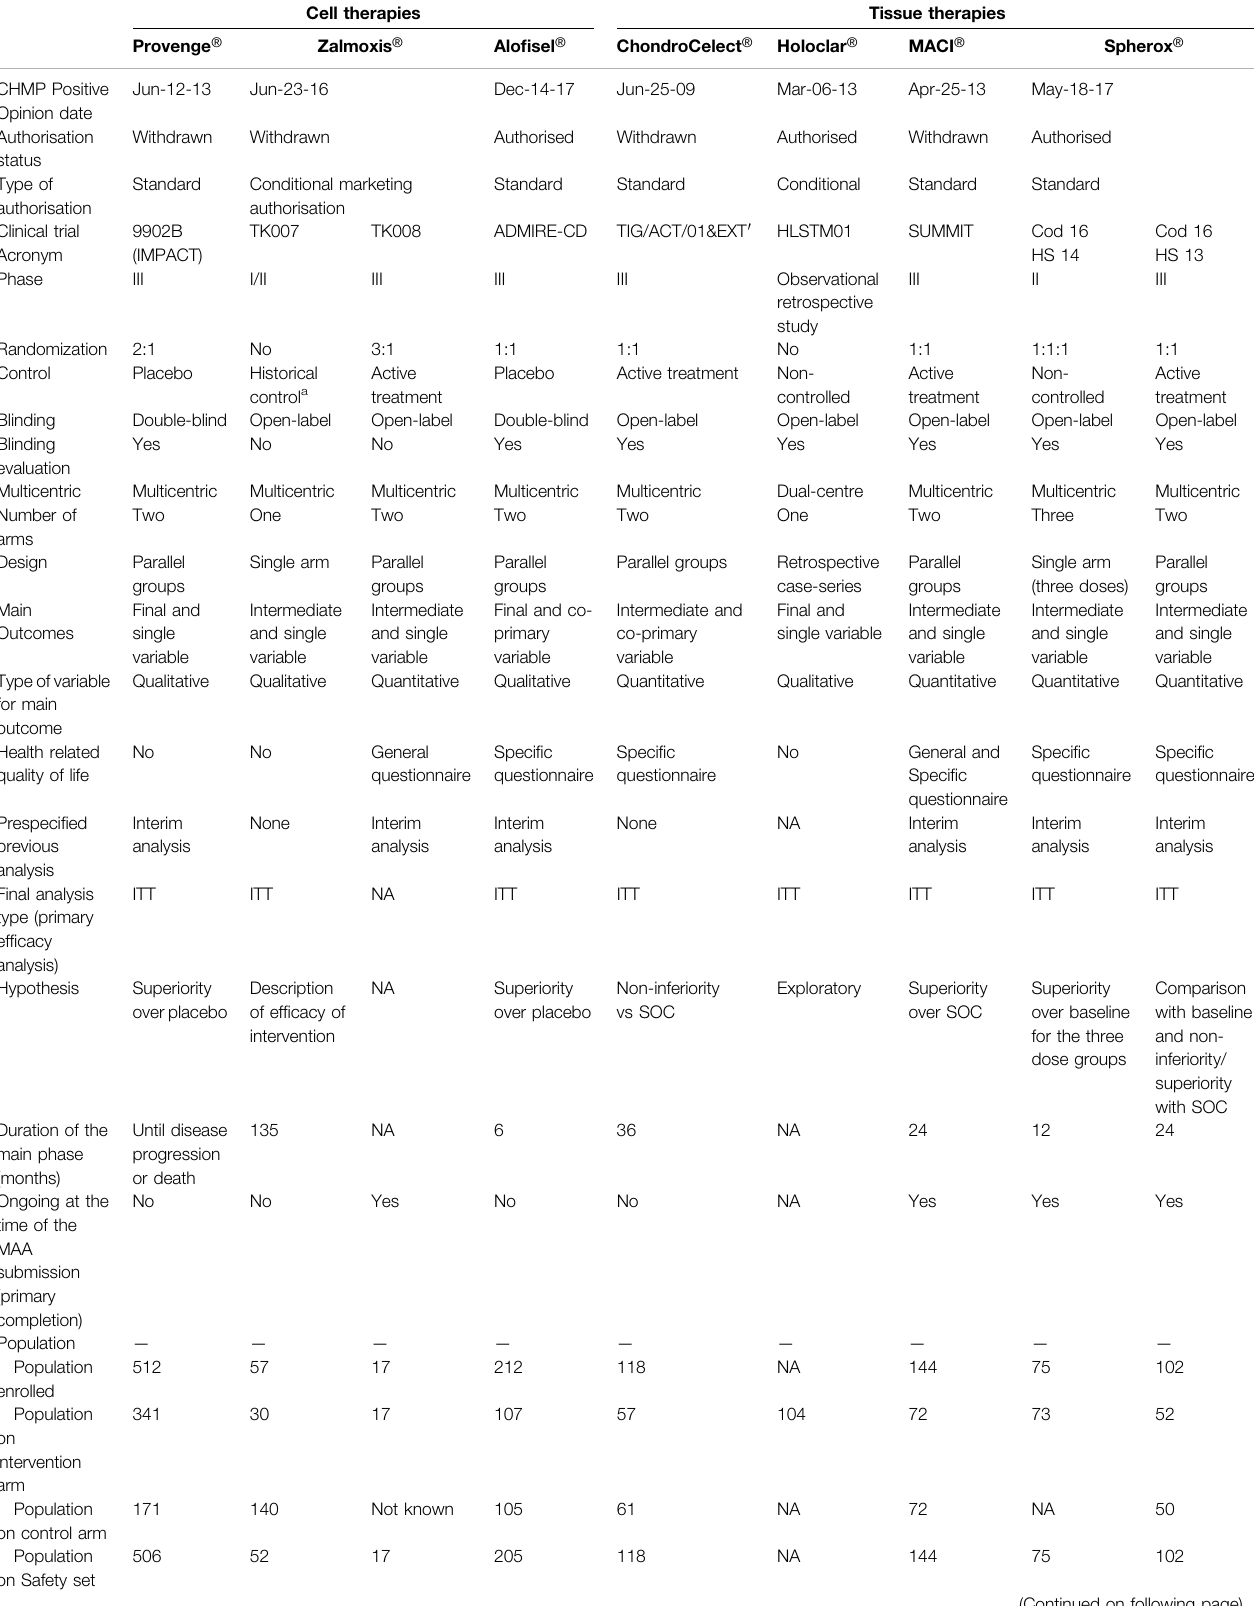
TABLE 4 | Design features of pivotal clinical trials for the approved cell and tissue engineered therapy medicinal products in the European